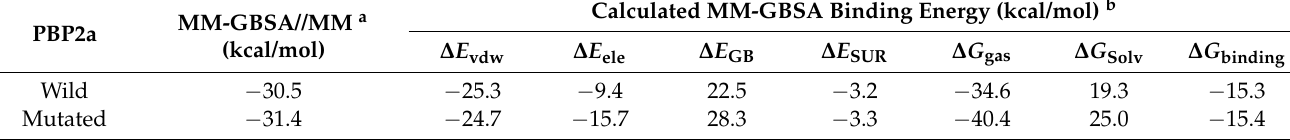
Table 1. Estimated MM-GBSA//MM and MM-GBSA//MD binding energies of QNZ with wild and mutated PBP2a allosteric site in acidic